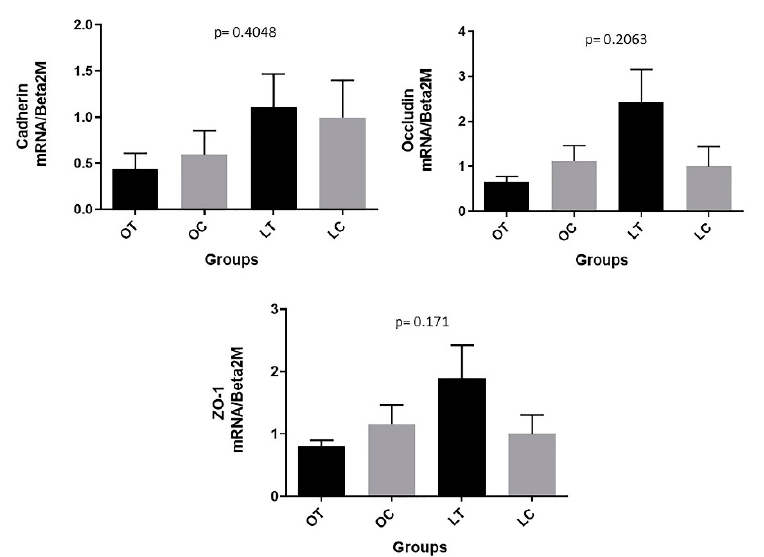
Figure A1. Cadherin, occludin and zonulin (ZO-1) expression in the gut of animals: obese control (OC), obese treated (OT), lean control (LC) and lean treated (LT) groups.